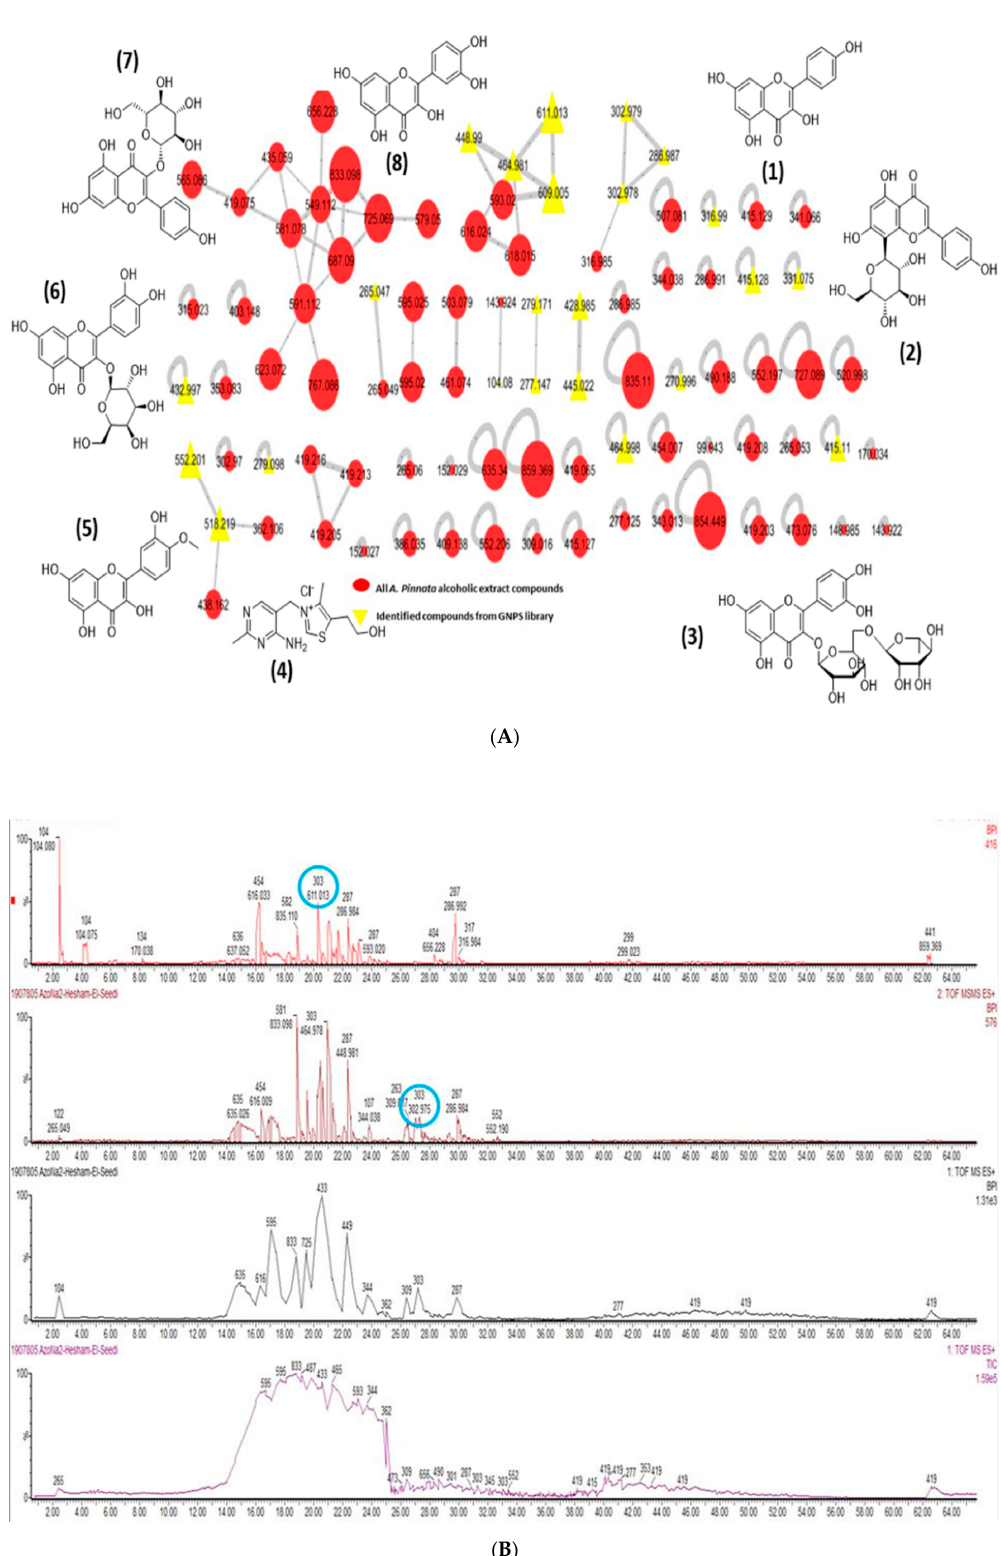
Figure 2. ( A ) Base peak MS chromatogram showing the major components of A. pinnata . ( B ) A. pinnata metabolite parent masses molecular network. The red circular nodes refer to all metabolite parent masses revealed from raw mass spectra. The yellow triangle nodes are for the identified metabolites from the Global Natural Product Social Molecular Networking (GNPS)